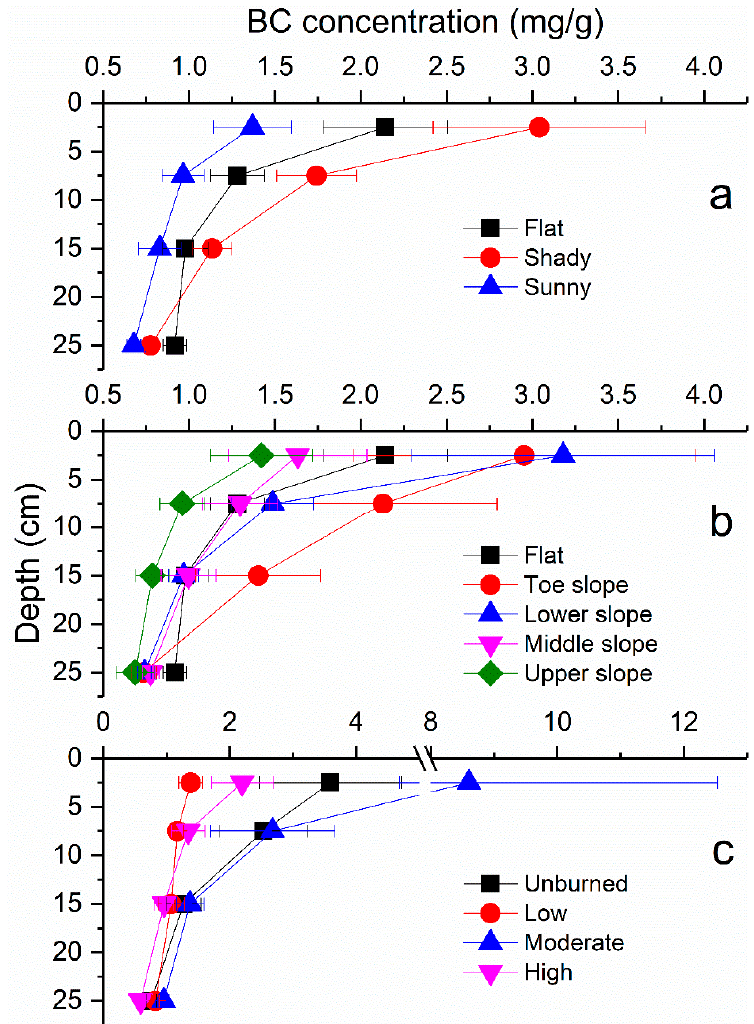
Figure 4. Soil BC concentrations on different aspects ( a ), on different slope positions ( b ) and of various fire severities ( c ) in the Great Khingan Mountains. Error bars indicate standard errors.